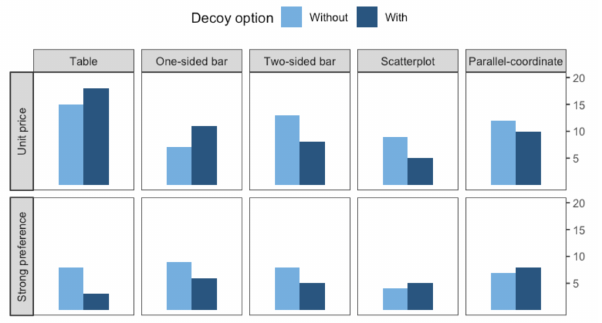
Figure 7. Frequency of each strategy mentioned by the participants in the interview. “I usually divided blue portion by the orange portion and went with which one was more.” “I determined the monthly price based on PPY [price per year] and what was provided. The charts provided a pretty accurate representation of those numbers/values.” On the other hand, there were some negative comments on scatterplots. Some partici- pants responded that scatterplots were not as helpful in making